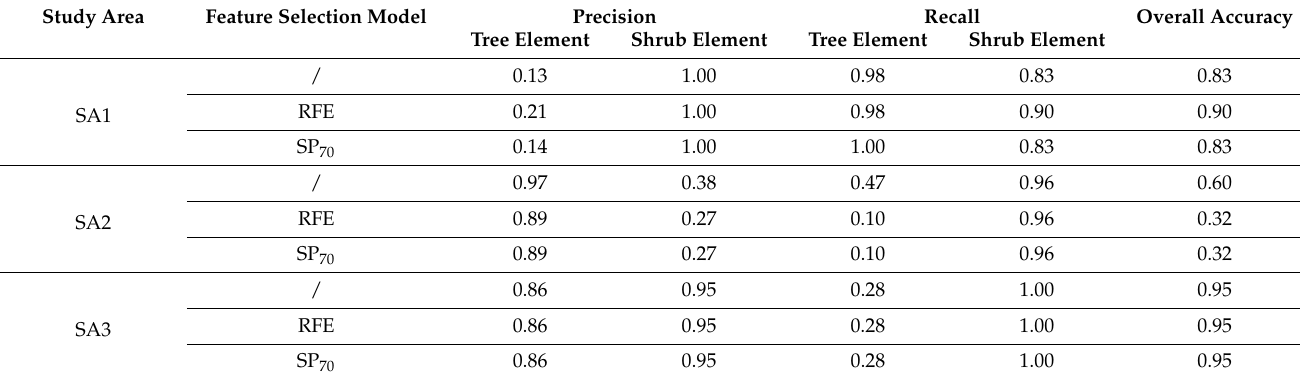
Table 7. Precision, recall, and overall accuracy of the Logistic Regression